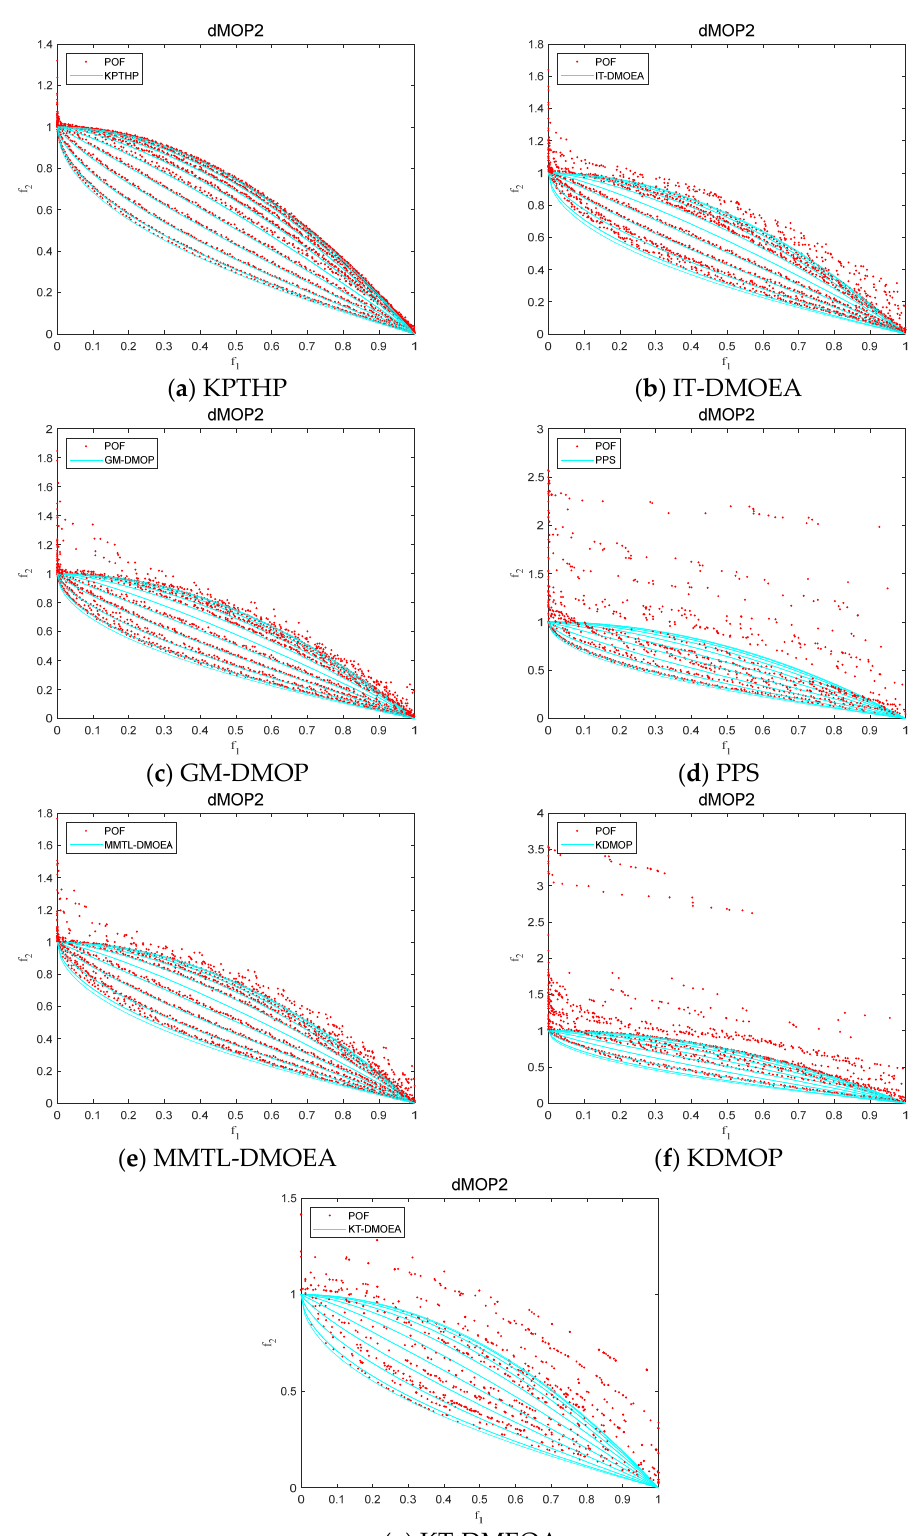
Figure 8. The POF of dMOP2 obtained by the seven algorithms.